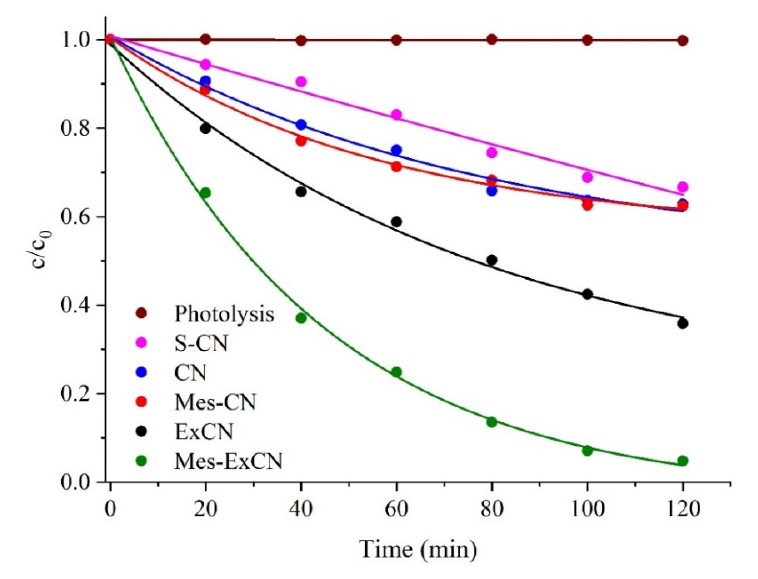
Figure 8. Photocatalytic decomposition of Acid Orange 7 (AO7) in aqueous dispersions of CN-based nanomaterials.